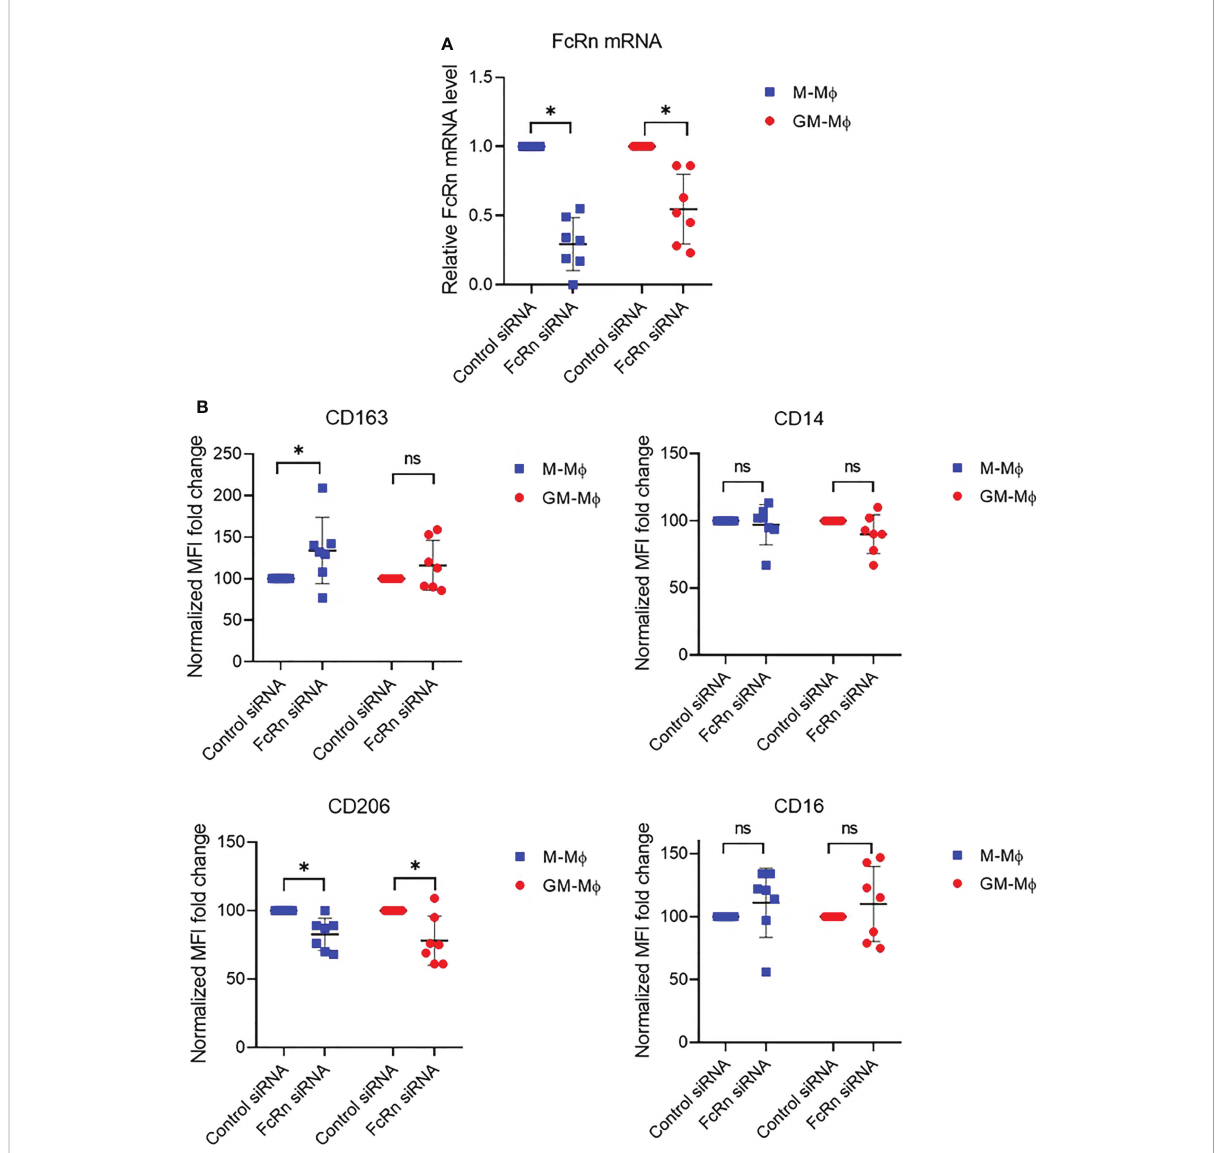
FIGURE 3 FcRn mRNA and differentiation marker expression after FcRn siRNA transfection. M-M f and GM-M f were transfected with FcRn siRNA on day 3 for 24 h. (A) Transfection ef fi ciency was assessed by RT-qPCR. Relative expression of FCGRT was normalized to that of actin and GAPDH. Data are relative FcRn levels to siRNA control (mean ± SD, N=7). (B) Flow cytometry of CD163, CD14, CD206 and CD16 expression after transfection in M-M f and GM-M f . Data are normalized MFI fold change to siRNA control (mean ± SD, N=7). M-M f , M-CSF – induced macrophages; GM-M f , GM-CSF – induced macrophages; MFI, mean fl uorescence intensity; ns, not signi fi cant. ns = not signi fi cant and *p ≤